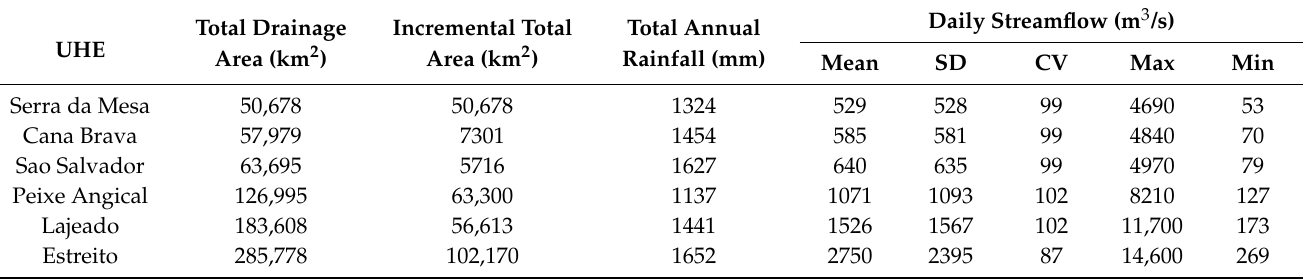
Table 6. Descriptive statistics of observed daily streamflow and precipitation for the period